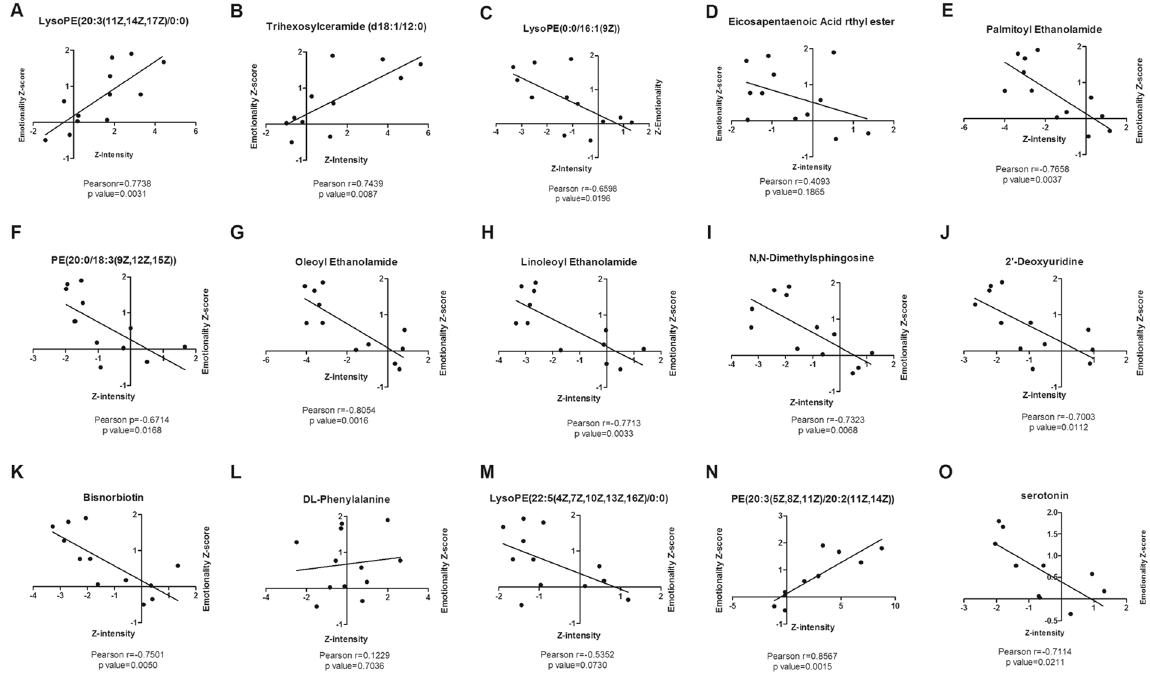
Figure 4. The correlation between the differential compound intensity Z-score and Emotionality Z-score. Emotionality Z-score included: the number of grooming, rearing and crossing in the OFT, the immobility time in the TST and